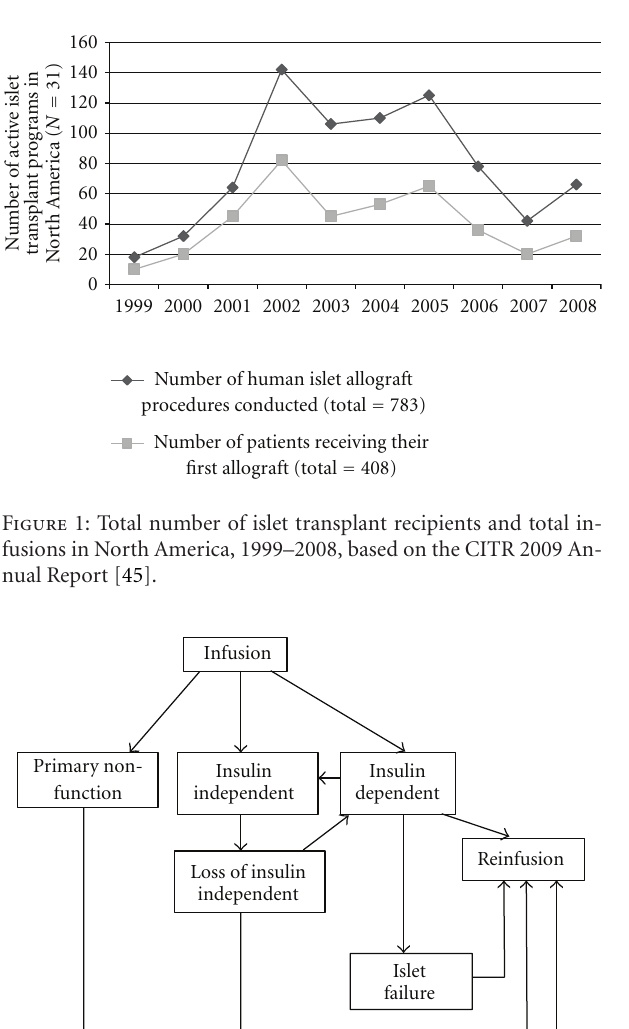
12% at month 6 to 42% at year 4. The proportion of patients retaining graft function with exogenous insulin over the three-year period remains in the range of 19–31%. Similar to IA recipients, postfirst infusion rates for IAK remain near 20%. Postlast infusion rates remain consistently below those of IA recipients through the four-year period as well. These trends of increasing graft loss and decreasing insulin inde- pendence over time following infusion prevail regardless of di ff er somewhat [45].